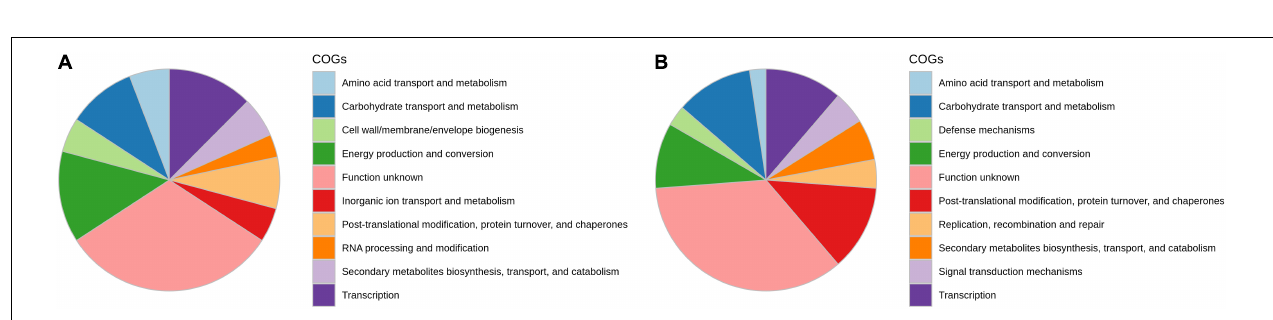
FIGURE 3 | Functional annotation of differentially expressed transcripts in response to PB in onion using orthologous groups (COG) categories; (A) AK and (B) AFR.